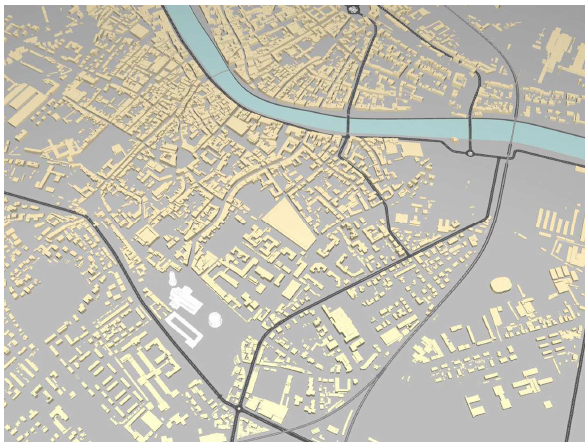
Figure 1. One step of the architectural